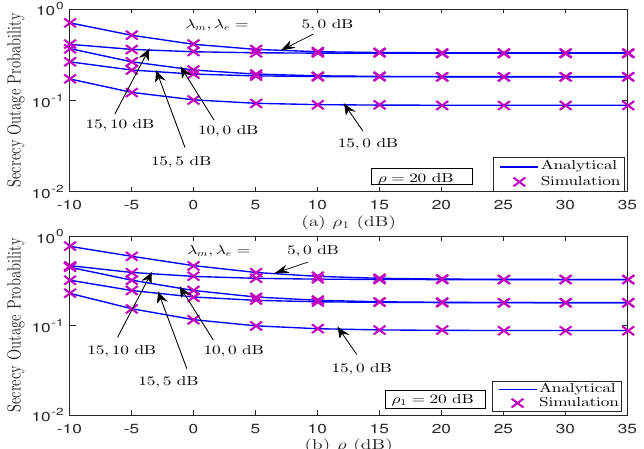
Figure 8. Impact of maximum tolerable interference level ( ρ = I P / N 0 ) and maximum transmit power constraint ( ρ 1 = Q / N 0 ) on the SOP performance under Strategy II.